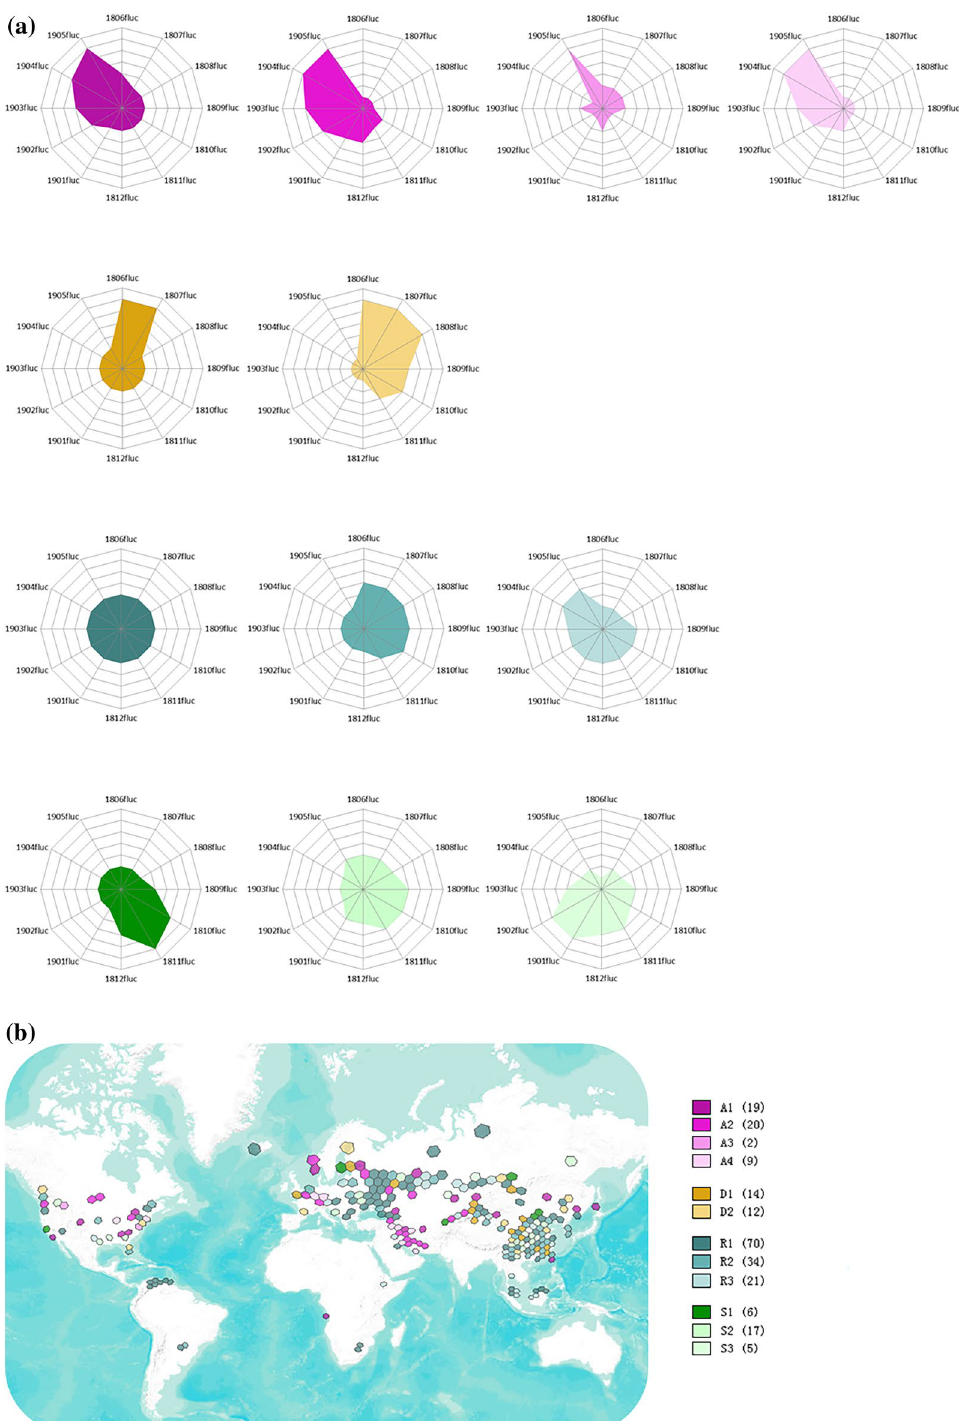
Figure 6. Classification of the grids with differentiated fluctuation patterns. ( a ) Grids with hash rate over 1500 TH/s (n = 229) are divided into twelve clusters in four groups. The twelve-month fluctuation indices of medoids are plotted in the radar chart as representatives of each cluster. ( b ) All the observed grids are plotted in Map ( b ) with their respective categories, sharing the sample colour scheme for each category in panel ( a) . Details of the results are provided in Supplementary Tables S5, S6 and the repository. The results are based on the monthly data from June 2018 to May 2019. The map is created by Geoda 1.18 (http:// geoda center. github. io/ downl oad.